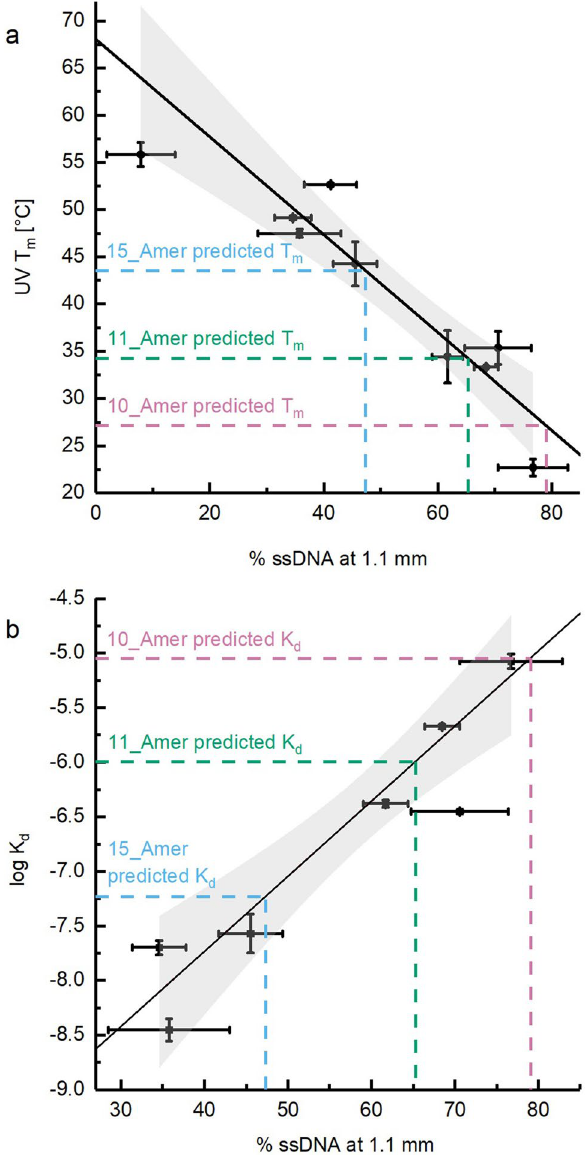
Figure 4. Linear models for predicting solution state binding affinities using the LILBID dissociation curve method and calculation of the solution state binding affinity of three dsDNA samples. Solution state binding affinities are plotted ( a : T m , b : log K d ) vs. % ssDNA at 1.1 mm (filled squares), shown as mean ± s.d. These points were fit with a linear fit weighted with the errors (s.d.) in x and y, using the York method 35 and assuming no correlation between errors in x and in y. These fits yielded the models shown here for predicting T m and log K d from LILBID dissociation curves. The light grey areas represent the 95% confidence intervals yielded from these fits. Also shown are the % ssDNA for the three test samples (10_Amer, 11_Amer and 15_Amer dsDNAs) and the solution state binding affinities predicted for them from the % ssDNA using the linear models. This figure was prepared in OriginPro 2017 (https ://www.origi